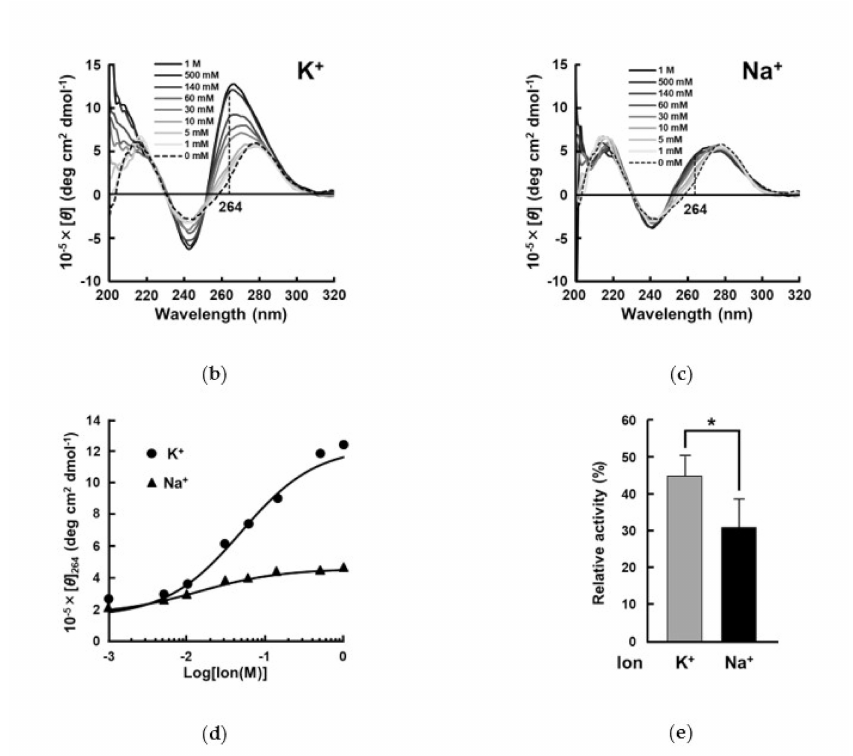
Figure 4. Ion-responsibility of M1D-Q5F aptamer. ( a ) Circular dichroism (CD) spectra of IRDAptamer library (0 mM ion, 140 mM Na + and 140 mM K + ). ( b ) CD spectra of M1D-Q5F aptamer (K + dependency). ( c ) CD spectra of M1D-Q5F aptamer (Na + dependency). (d) Monitoring ion-responsive structure switching of M1D-Q5F aptamer by CD spectra at 264 nm (circle, K + ; triangle, Na + ). ( e ) E ff ects